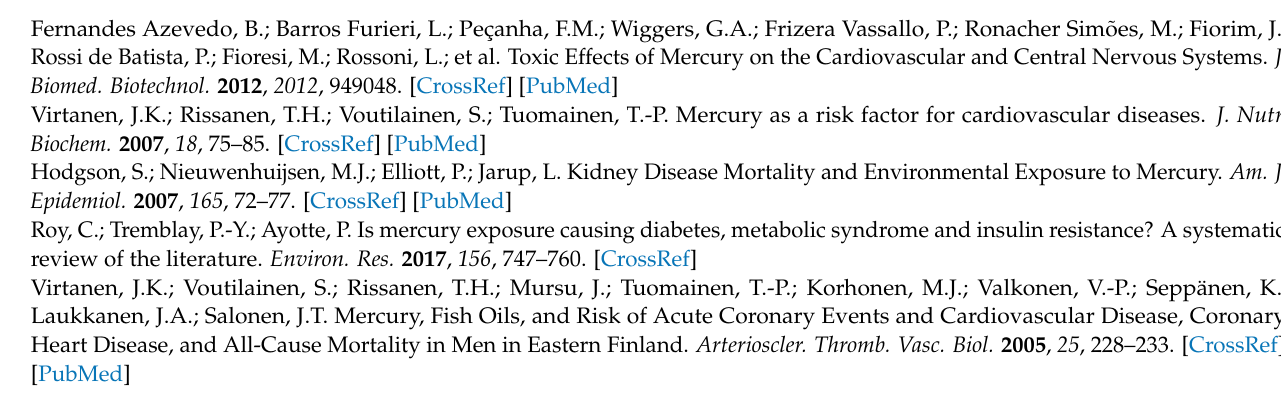
cents, Table S2: Baseline characteristics of the study participants according to TG and HDL-cholesterol levels, Table S3: Covariates according to blood Hg distribution, Table S4: Associations between blood Hg concentration and prevalence of hypercholesterolemia and hyper-LDL cholesterolemia according to sex, Table S5: Associations between blood Hg concentration and prevalence of overt hypercholes- terolemia and hyper-LDL cholesterolemia according to